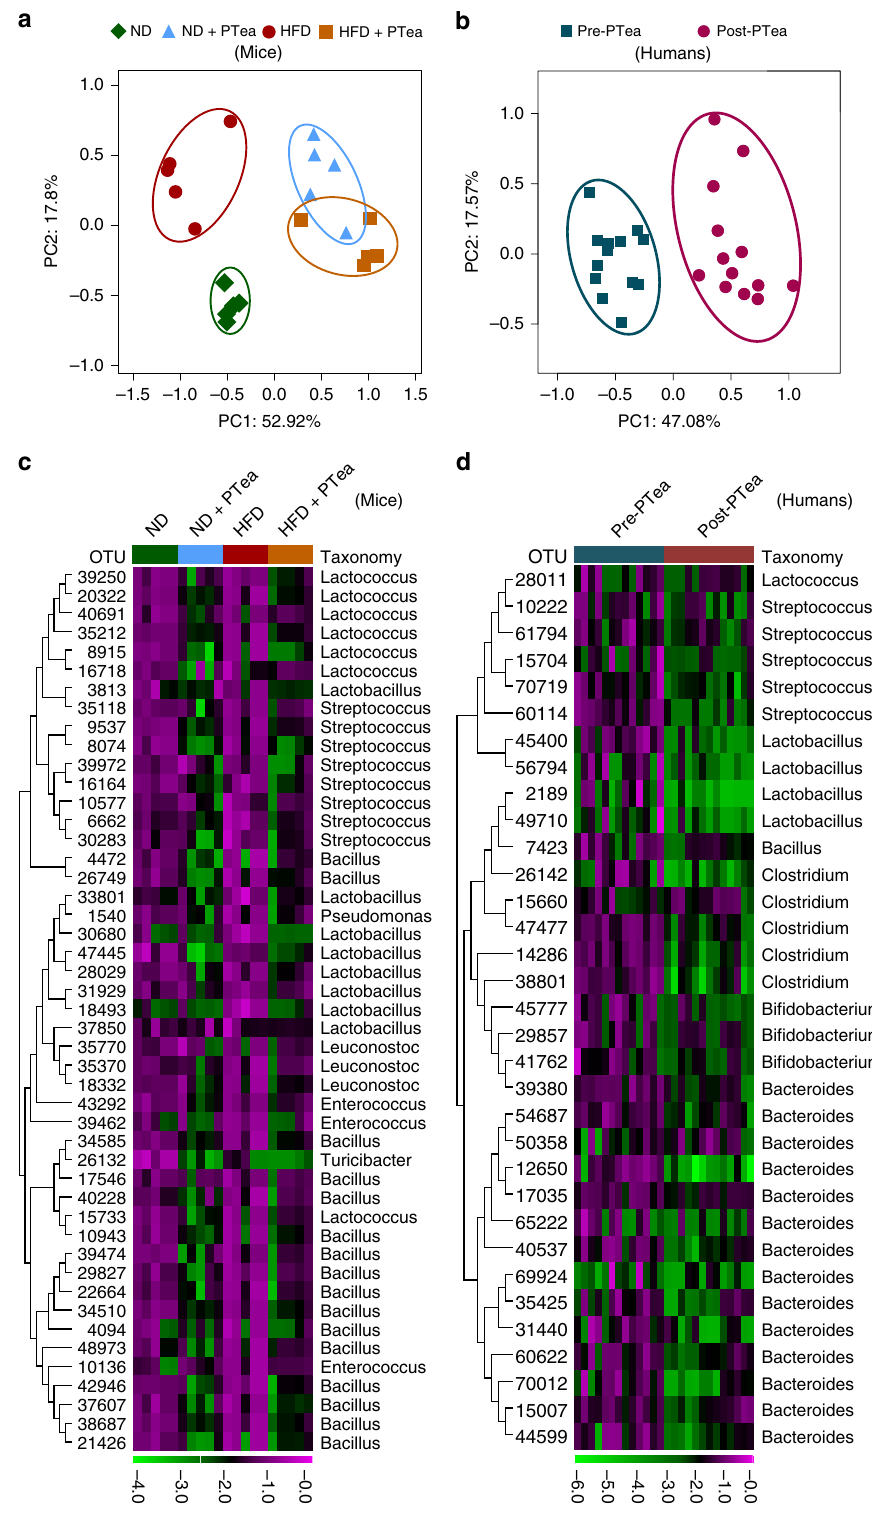
Fig. 2 Pu-erh tea reshaped the gut microbiota in mice and human. a Principle coordinate analysis (PCoA) plot based on the OTU matrix of mouse ileal microbiota in ND, ND + PTea, HFD and HT + PTea groups. n = 5 individuals/group. b PCoA plot based on the OTU matrix of human fecal microbiota. n = 13 individuals/group. c Heatmap of the relative abundance of representative OTUs at the genus and species levels in mice. Part of the OTUs which were simultaneously reduced by Pu-erh tea in both normal diet and HFD are shown, which can be referenced to the OTUs in blue outline of the full fi gure (Supplemantary Fig. 6a). n = 5 individuals/group. d Heatmap of the relative abundance of representative OTUs at the genus and species levels in humans. n = 13 individuals/group. Part of the OTUs which were reduced by Pu-erh tea similar to mice are shown, which can be referenced to the OTUs in blue outline of the full fi gure (Supplemantary Fig. 6b). The color of each spot in the heatmap corresponds to the normalized and log-transformed raw abundance of the OTUs in each sample. The OTUs were organized according to their order in the phylogenetic tree generated by their representative